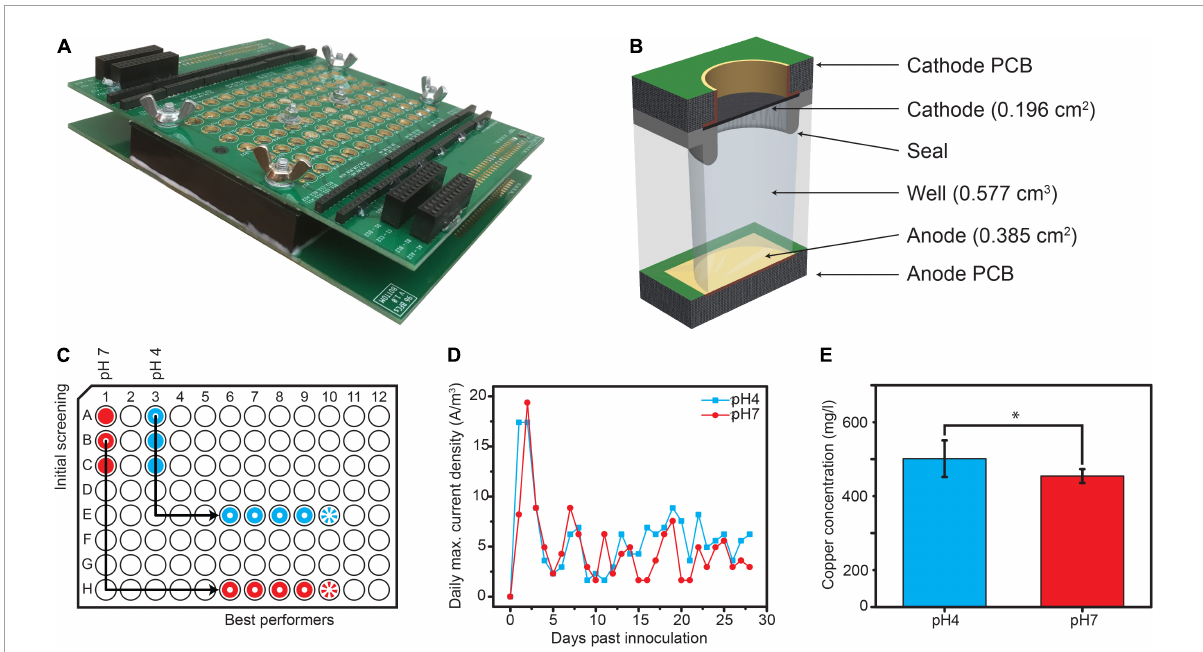
FIGURE1 (A) Overview. (B) Cross-section of the used array. (C) Experimental setup, with the wells marked red being the pH 4 group, wells marked blue being the pH 7 group and wells with rays being the open circuit potential (OCP) controls. (D) Daily maximal current densities measured post inoculation. (E) Cu concentrations measured from the effluent samples of each well. Statistical significance was tested using ONE-way ANOVA ( ∗ p -value <